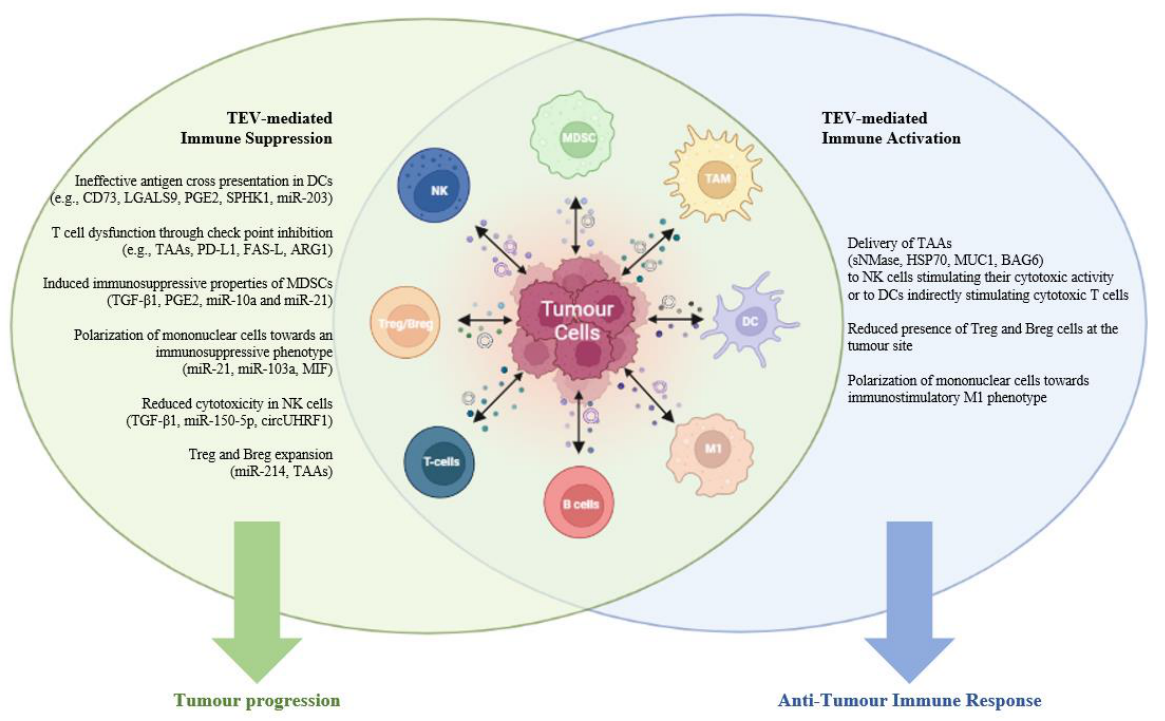
Figure 1. Tumor-derived EVs regulate immune system cells’ functions. TEVs can promote tumor progression by suppression of innate and adaptive immune cells, as indicated in the left green panel. In fact, TEVs hamper effective antigen cross presentation in DCs, contribute to T cell dysfunction through check point inhibition, polarize mononuclear cells towards an immunosuppressive phenotype, induce immunosuppressive properties of MDSCs, promote Treg/Breg expansion and reduce NK cells cytotoxicity activity. TEVs can also promote tumor recognition enhancing anti-tumor immune functions, as shown in the right blue panel. During a functional immune response, TEVs deliver TAAs to NK cells to stimulate their cytotoxic function or to DCs to indirectly stimulate cytotoxic T cells, to polarize mononuclear cells towards an immunosuppressive phenotype. Macrophages can actively uptake TEVs from circulation promoting cancer cell recognition. Examples of molecules involved in these mechanisms are also indicated. (EVs, tumor-derived extracellular vesicles; TAAs, tumor-associated antigens; NK, natural killer; Treg, regulatory T cells; MDSC, myeloid-derived suppressor cells; DCs, dendritic cells; sNMase, neutral sphingomyelinase; HSP70, heat shock protein 70; MUC1, mucin-1; BAG6, large proline-rich protein BAG6; PD-L1, programmed death-ligand 1; FAS-L, tumor necrosis factor ligand superfamily, member 6; ARG1, arginase-1; TGF- β , transforming growth factor beta; LGALS9, galectin 9; MIF, macrophage migration inhibitory factor; SPHK1, sphin- gosine kinase 1, PGE2, prostaglandin E2). Figure generated with the aid of BioRender.com (adapted from “Pro- and Anti-Tumor Immune Cells in the Tumor Microenvironment biorender”, accessed on 15 November